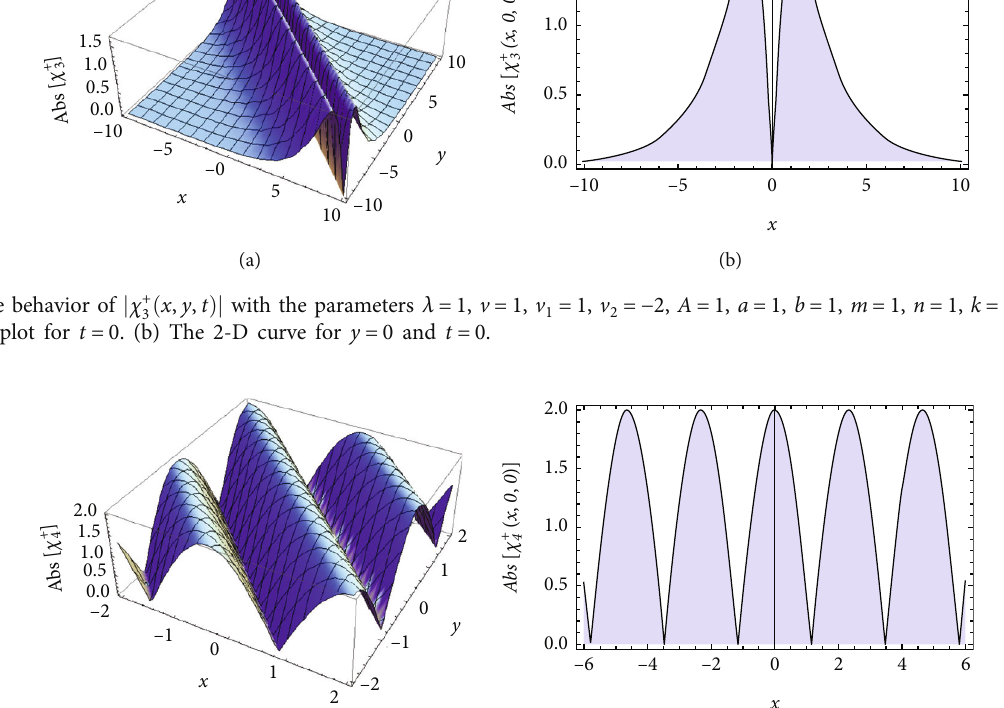
= 1 , v = − 2 , A = 1 , a = 1 , b = 1 , m = 1 , n = 1 , k = 1 , and 1 2